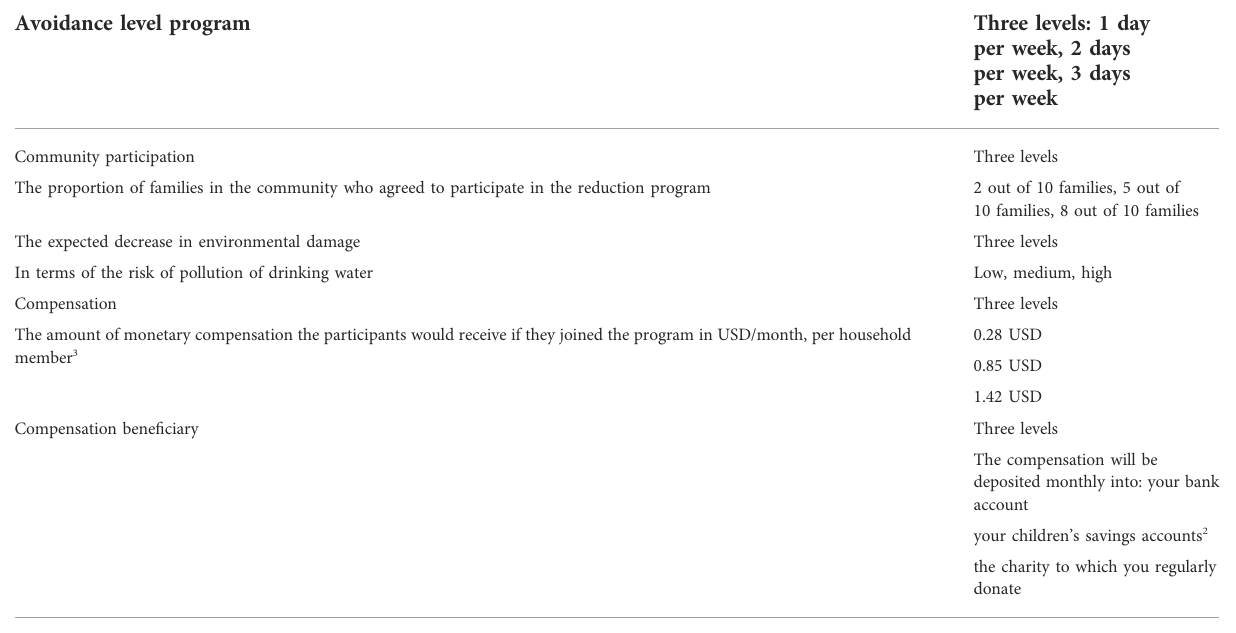
TABLE 1 Attributes and their levels employed in the design.